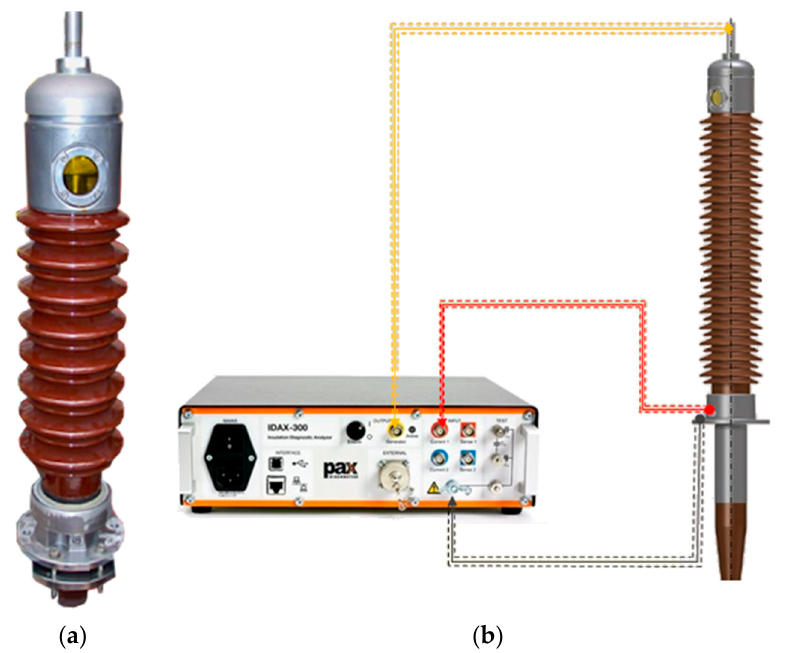
Figure 3. COT-250-800 Trench transformer bushing ( a ), method for connecting the test bushing to the IDAX 300 m ( b ).